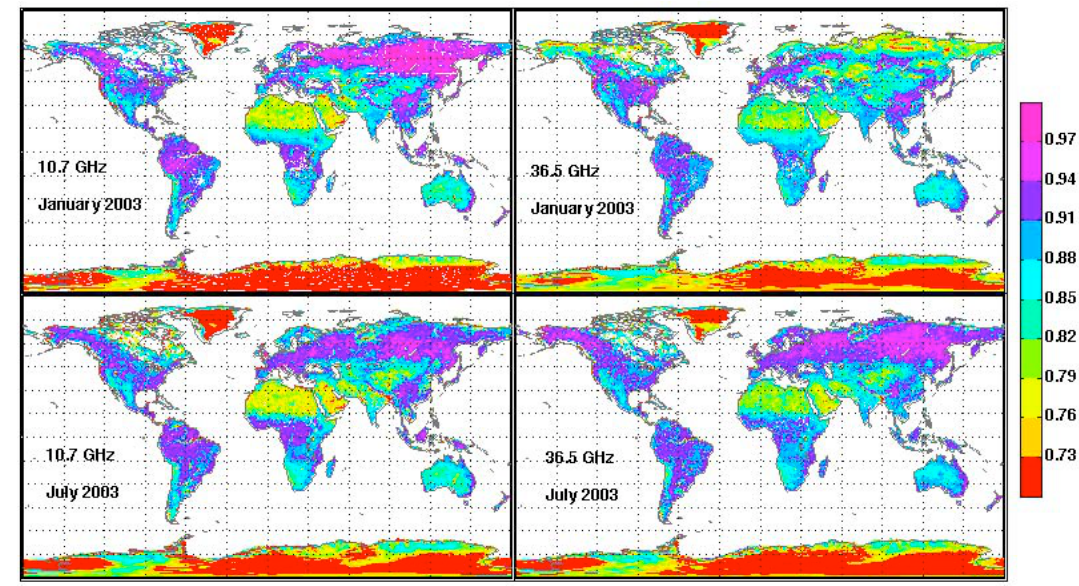
Fig. 2. Composite monthly mean land surface emissivity at 10.7, and 36.5GHz (horizontal polarization) for January and July